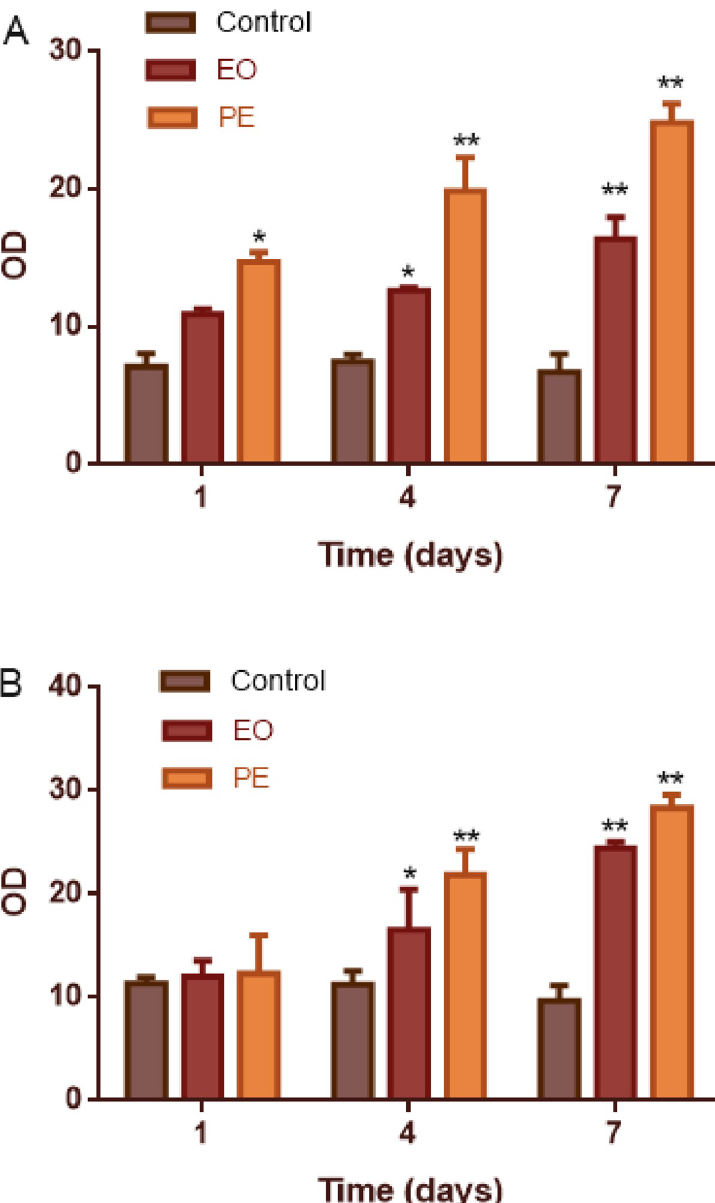
Fig 2. OD value of BMP-2OCN in young adult rats with anterior palatal suture expansion model and PDTC intervention. A: BMP-2; B:OCN; � Statistically significant increase versus the control group ( � p < 0.05, �� p < 0.01); EO: expansion only group; PE: expansion plus PDTC